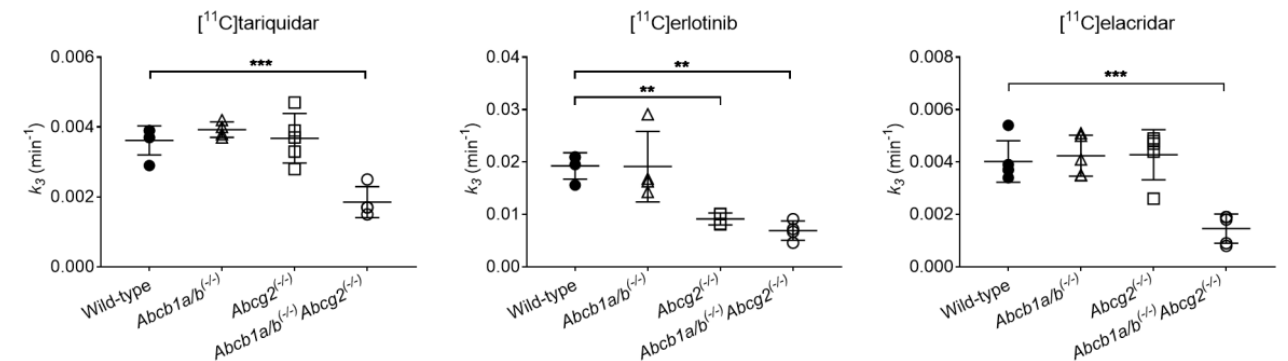
Figure 5. Rate constant ( k 3 ) representing the transfer of radioactivity from liver to excreted bile (intestinal region of interest)